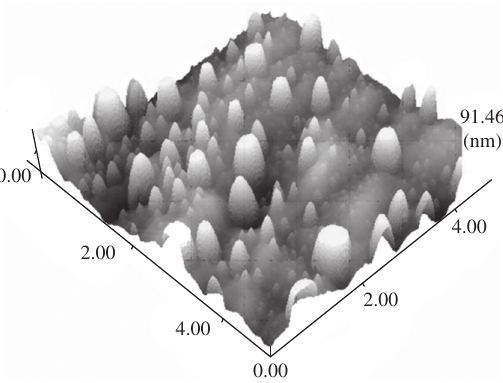
-CaO-P O biofilm coated 2 2 5